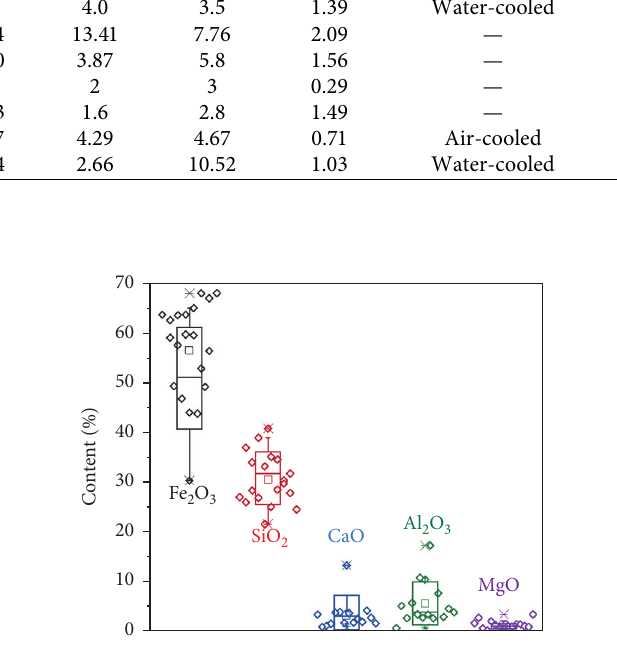
Figure 3: Statistical chart of content of copper